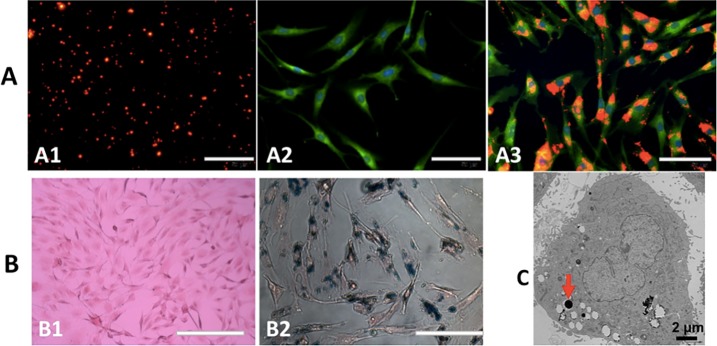
Identification of PLGA/IO MPs internalized within TSCs.(A) fluorescent staining of PLGA/IO MPs (A1, red), TSCs before (A2, cytoplasm as green, nuclear as blue) and after labeling with PLGA/IO MPs (A3, red particles aggregated in the cytoplasm). (B) Prussian blue staining of non-labeled cells (B1) and labeled cells (B2), blue-green staining PLGA/IO MPs were present in the cytoplasm, mostly around the nuclei). (C) TEM of labeled TSCs showed that high density PLGA/IO MPs (the arrow) were in the cytoplasm.